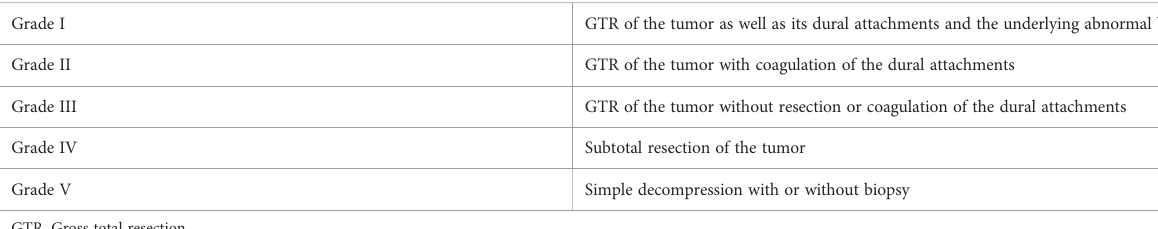
TABLE 3 Simpson grading in